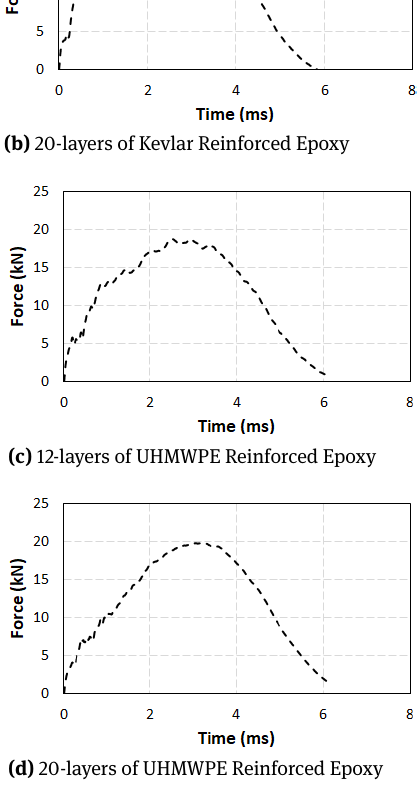
Figure 2: Force-Histories experimental